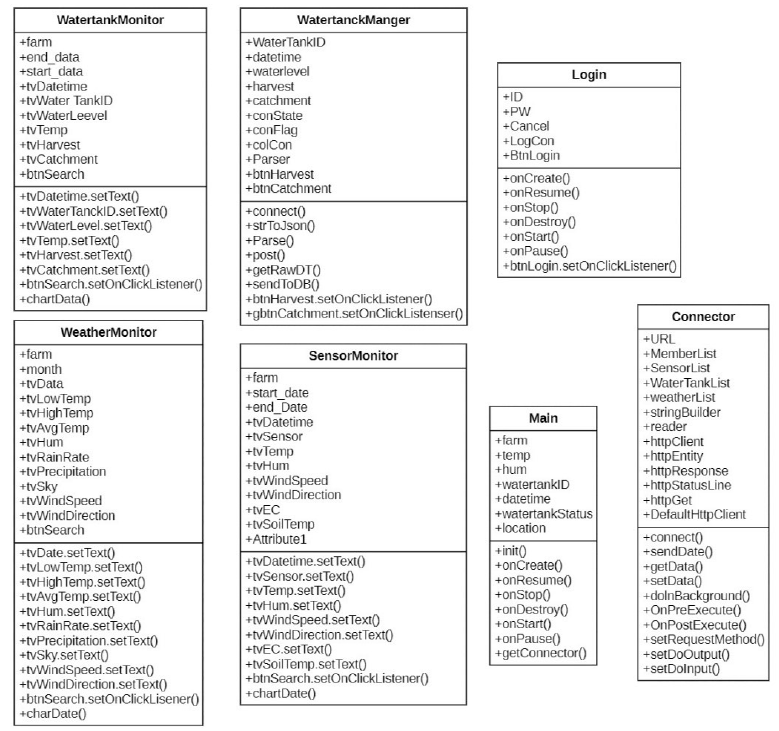
Figure 6. User smartphone application class diagram.